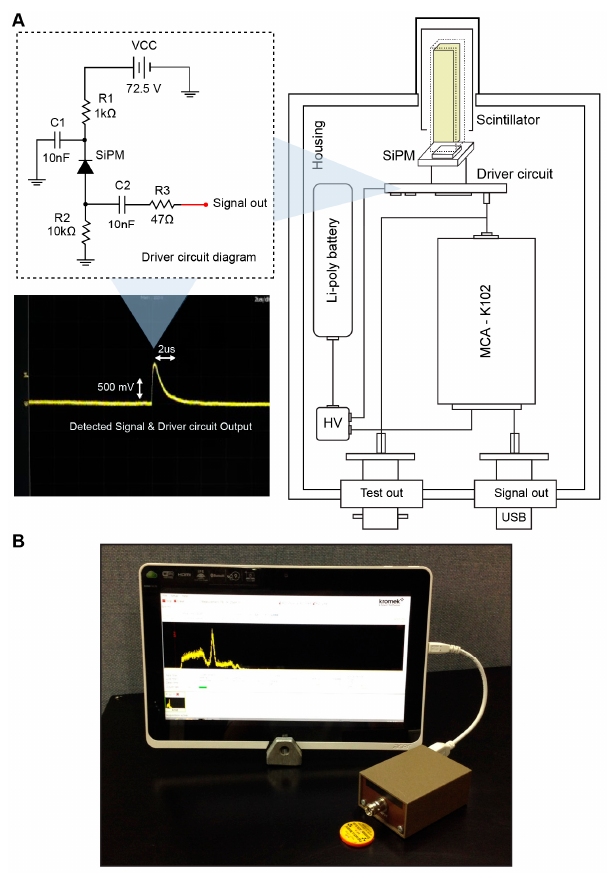
Figure 2. ( A ) Personal-Spect structure and ( B ) overall spectroscopy system.